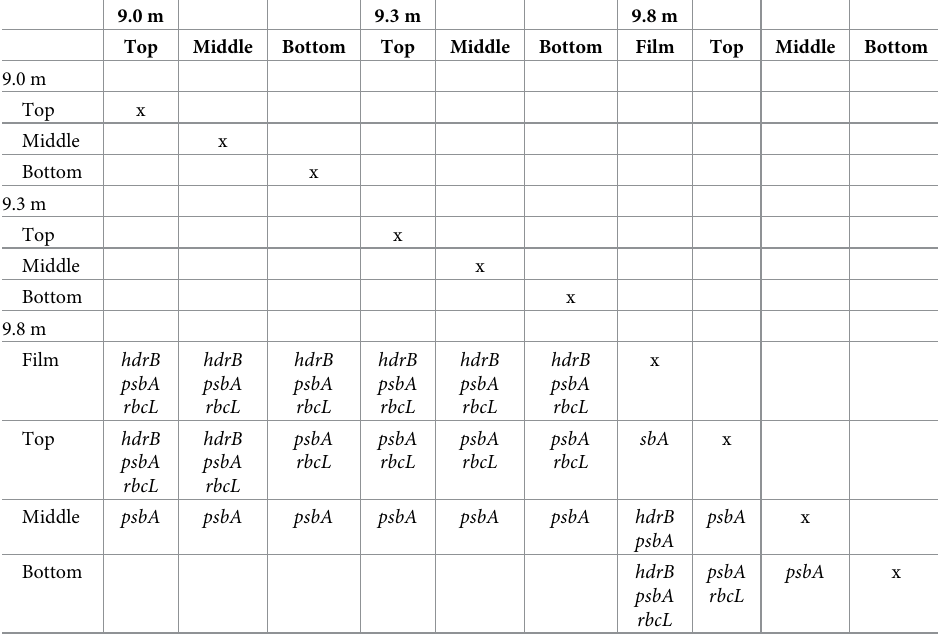
Table 6. Significant differences in metabolic marker genes.